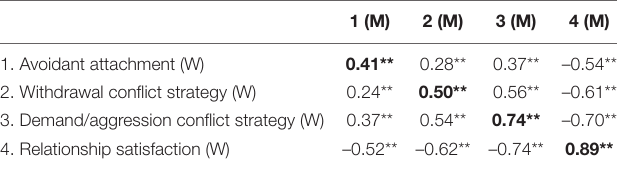
TABLE 4 | Dyadic correlations among study variables for coupled women and